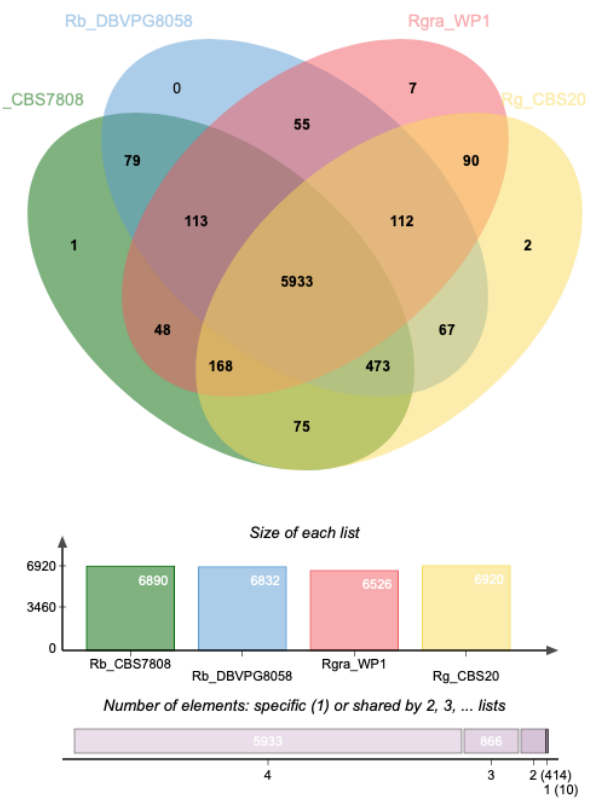
Figure 6. Distribution of shared orthologous clusters between Rhodotorula babjevae strains CBS 7808 and DBVPG 8058, R. graminis WP1 and R. glutinis CBS 20. The Venn diagram was generated using OrthoVenn2.